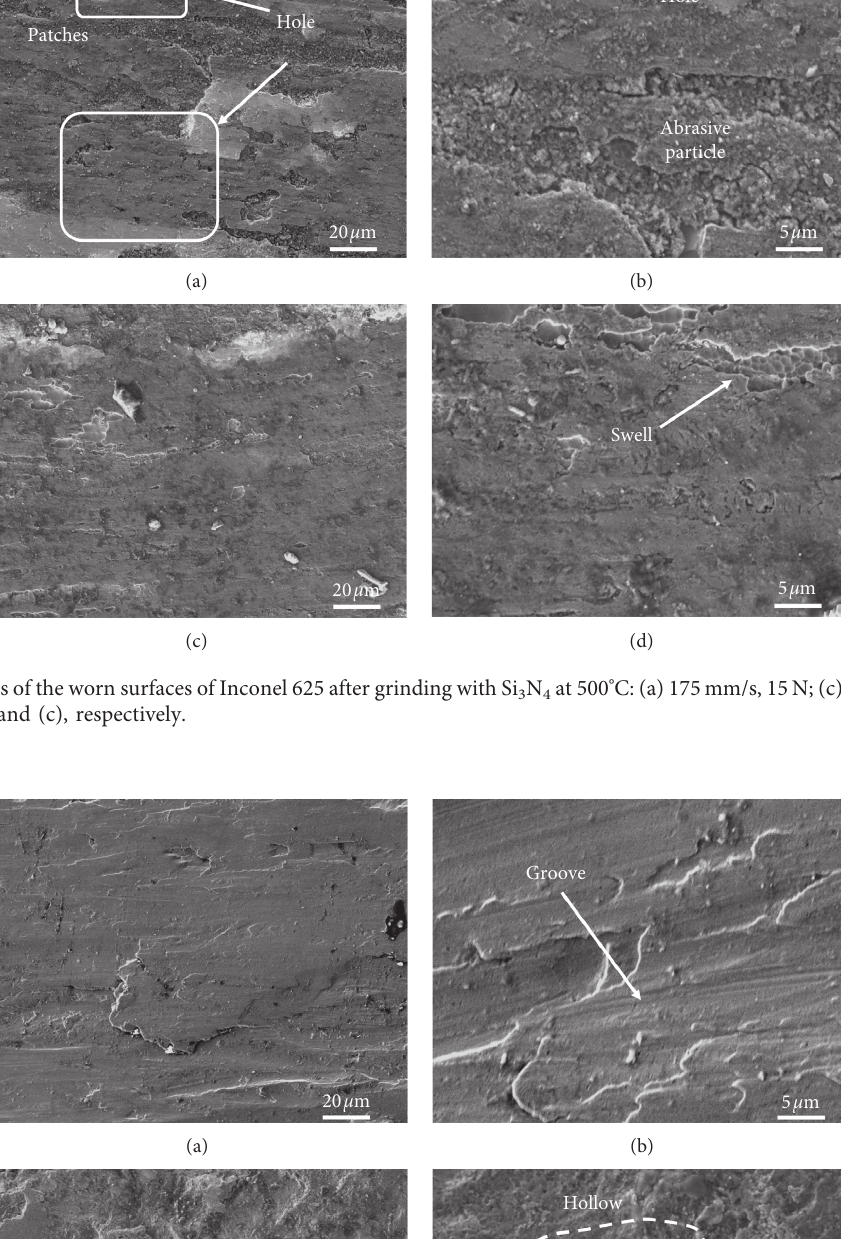
° C: (a) 175mm/s, 15N; (c) 350mm/s, 15N; 3 N 4 grinding at 25